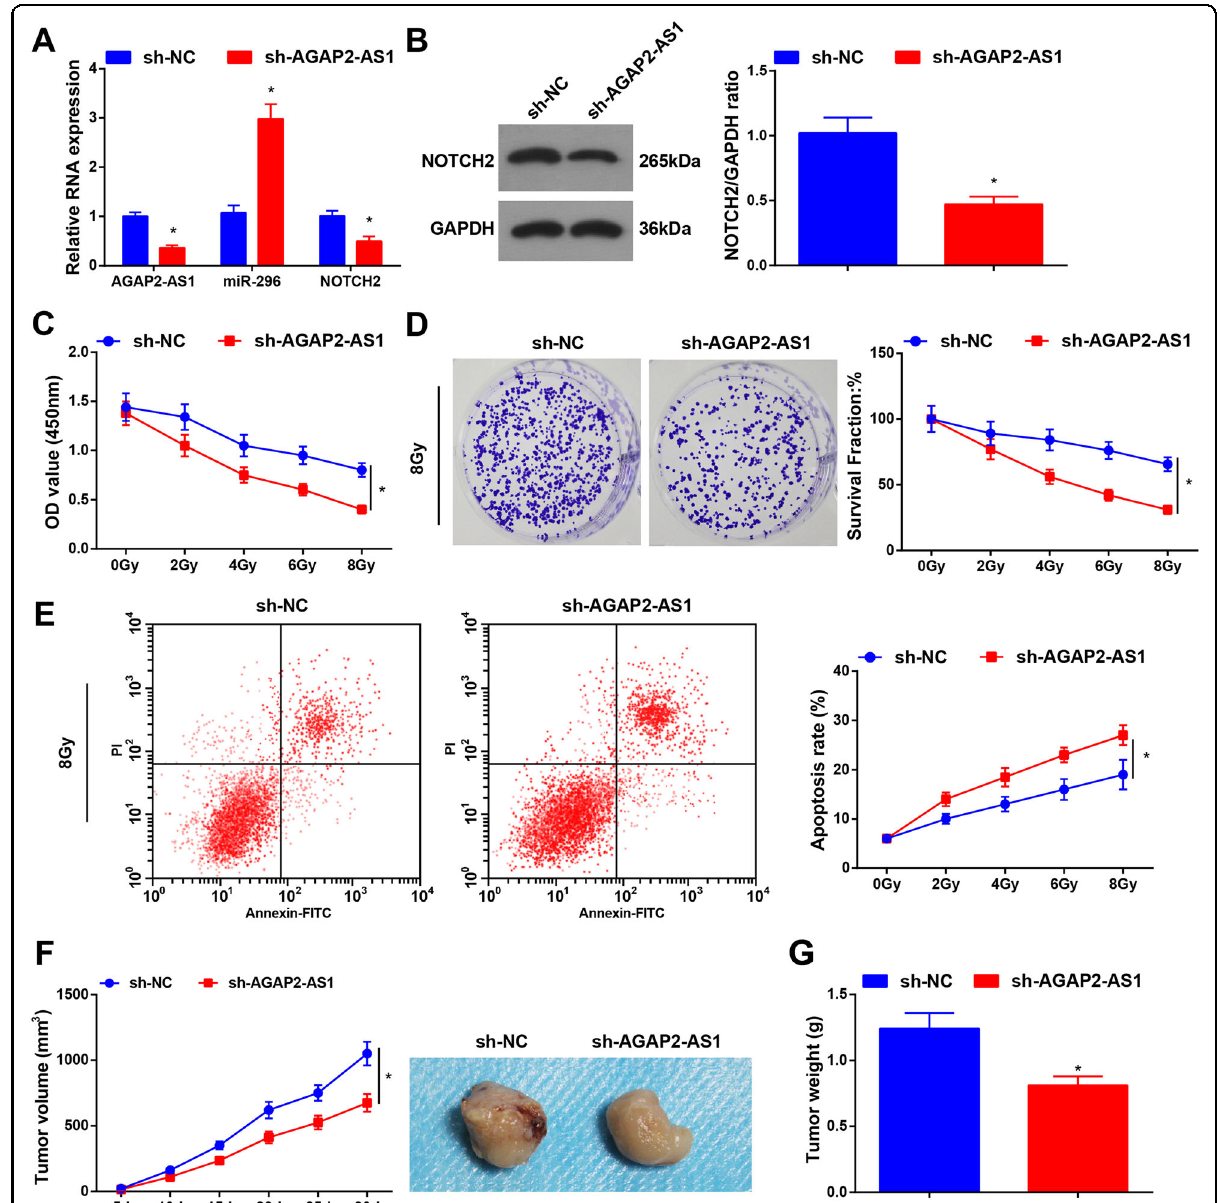
Fig. 3 Inhibited AGAP2-AS1 restricts radioresistance of radioresistant lung cancer cells. A Expression of AGAP2-AS1, miR-296, and NOTCH2 in A549R26-1 cells was detected by RT-qPCR. B Protein expression of NOTCH2 in A549R26-1 cells was determined by Western blot analysis. C Viability of radioresistant lung cancer cells A549R26-1 was measured using CCK-8 assay. D Colony formation ability of radioresistant lung cancer cells A549R26-1 was evaluated by colony formation assay. E Apoptosis of radioresistant lung cancer cells A549R26-1 was determined by fl ow cytometry. F Volume of xenografts from nude mice that had been injected with radioresistant lung cancer cells A549R26-1; G weight of xenografts from nude mice that had been injected with radioresistant lung cancer cells A549R26-1; N = 3 in the cellular experiment and n = 6 in the animal experiment; * P < 0.05 vs. the sh-NC group; the measurement data were expressed as mean ± standard deviation, one-way ANOVA was used for comparisons among multiple groups and Tukey ’ s post hoc test was used for pairwise comparisons after one-way